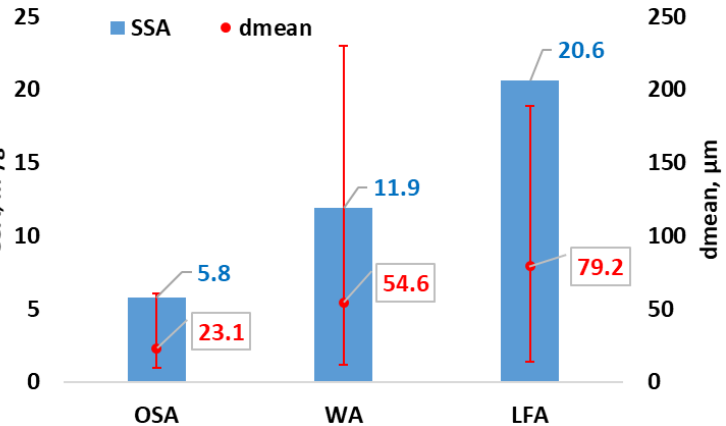
Figure 2. Average particle diameter (d mean ) and specific surface areas (SSA) of OSA, WA, and LFA samples.